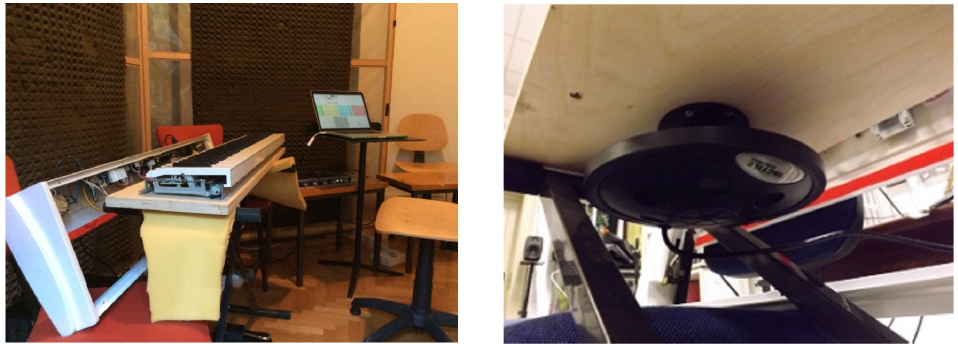
Figure 9. Experimental setup for studying vibrotactile feedback on digital piano ( right ). One of the transducers used to convey vibration at the keyboard ( left